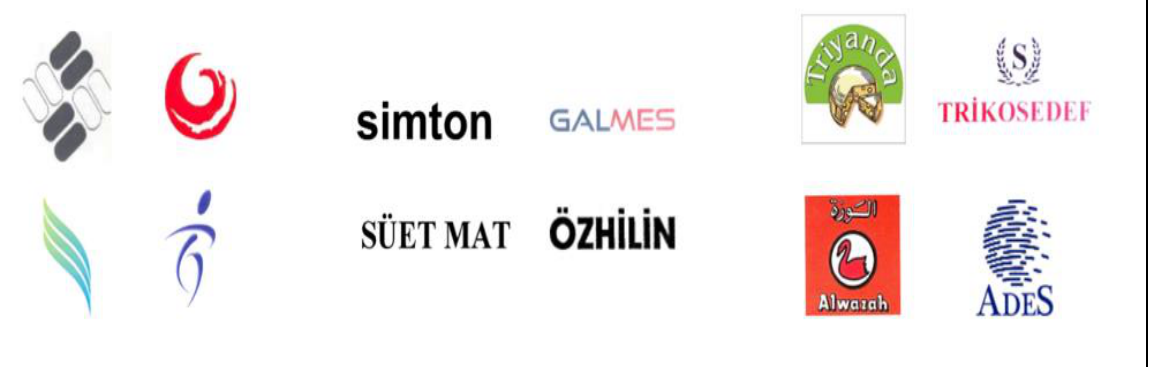
Figure 2. Middle East Technical University data samples that contain figures only, text only, and both.